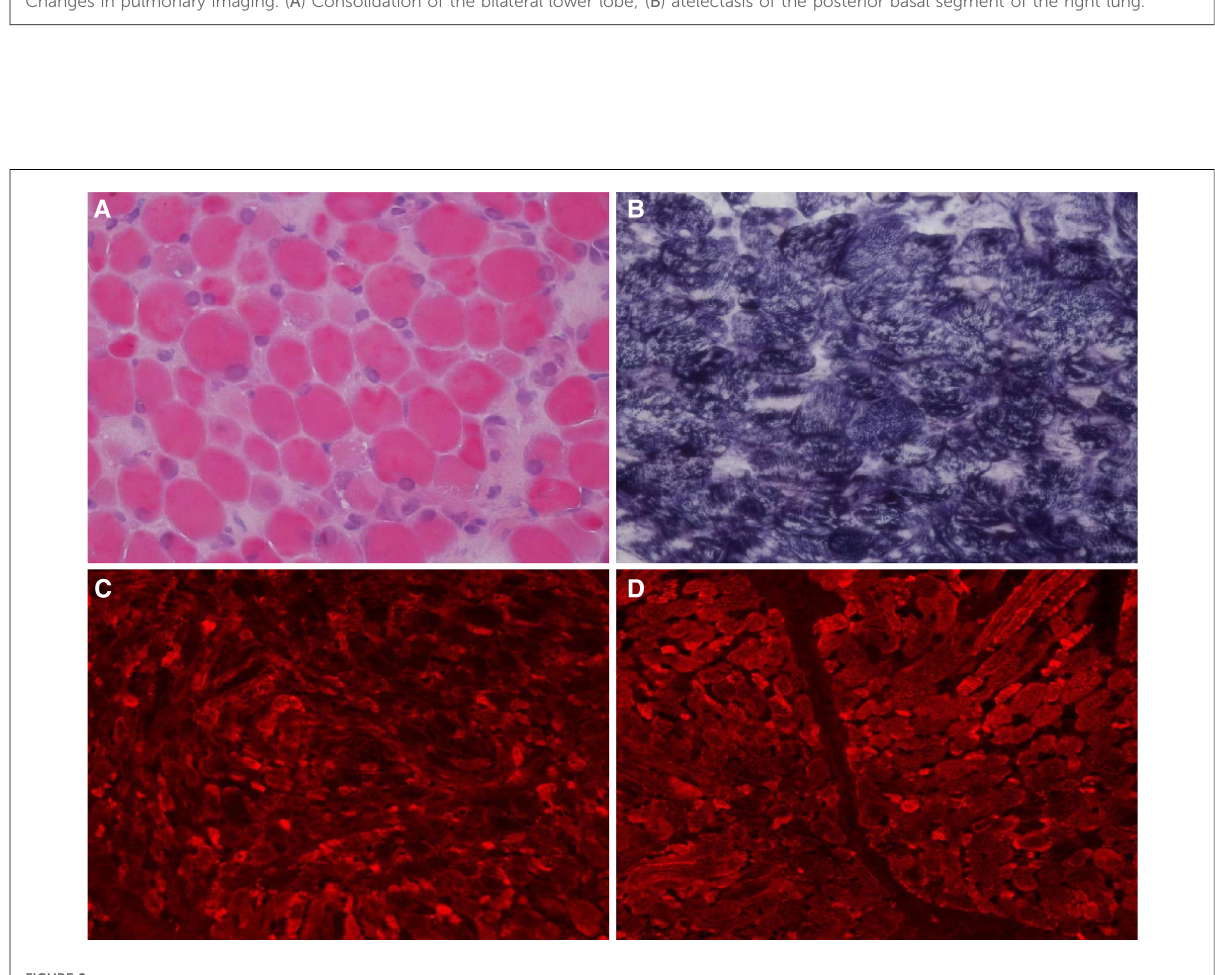
FIGURE 2 Histochemical and immunohistochemical staining of muscle biopsies (×200). Following HE staining ( A ), different sizes of muscle fi bers were observed, and degeneration, necrosis, and regeneration of the muscle fi bers was evident as well as the deposition of amorphous materials. Some muscle fi ber staining was signi fi cantly darker than the surrounding myo fi brils according to modi fi ed Gömöri trichrome staining ( B ). Fluorescence antibody staining of desmin, α -crystallin ( C ), and myotilin ( D ) revealed high expression levels of these proteins in the